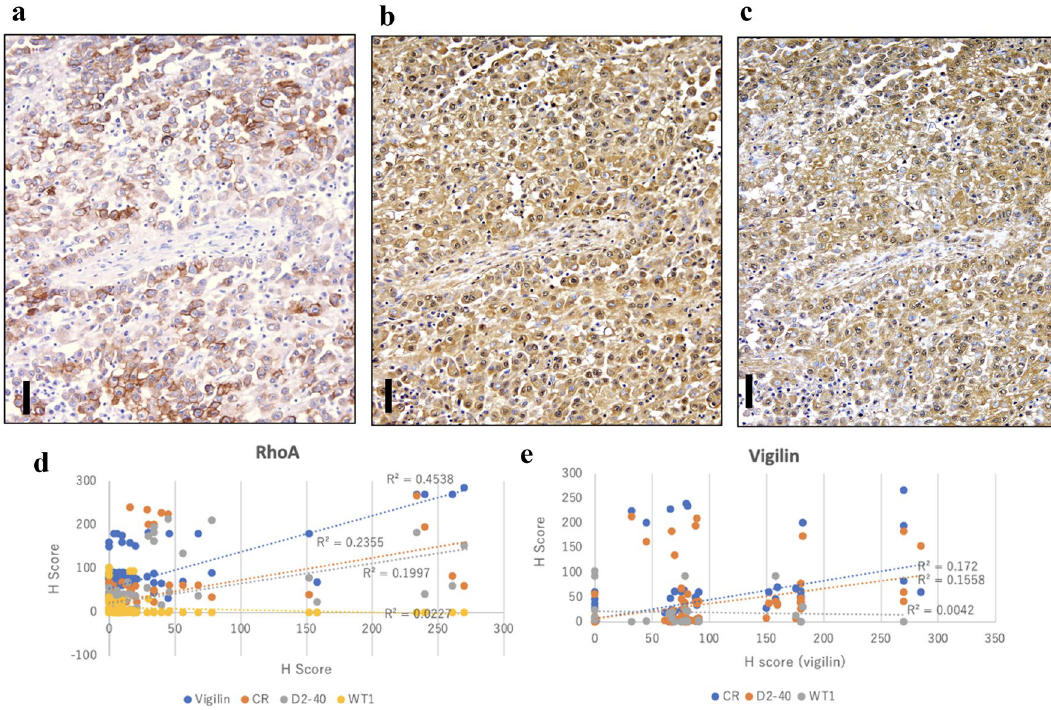
Figure 3. Immunohistochemistry of epithelioid malignant mesothelioma. ( a ) D2-40, ( b ) RhoA, ( c ) vigilin. Scale = 50 µm. Original magnification is 200 × for all. ( d , e ) Correlation analysis on H-Score. The horizontal axis represents the H-score of RhoA(left) and vigilin(right). The vertical axis represents each score of vigilin, calretinin(CR), D2-40, andWT-1. The regression lines are added to the plot graphs. Squares of each correlation coefficient are